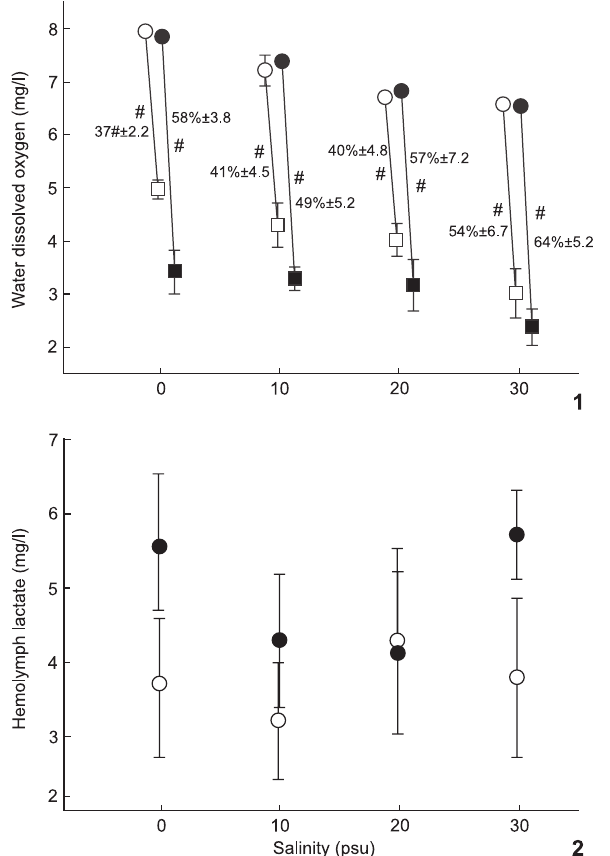
Figures 1–2. Initial (circles) and final (squares) levels of dissolved oxygen in the water (1) and lactate concentration in the hemolymph (2) of M. acanthurus exposed to salinities 0 (control), 10, 20, and 30 psu for 4 (white symbols) and 8 hours (black symbols). Values near to the lines represent oxygen consumption (mean ± std dev) as a percentage of the initial oxygen concentration (considered 100%, as a reference value). (#) Initial and final levels of dissolved oxygen are different. There were no significant differences between salinities or times (4 and 8 hours) for oxygen consumption and lactate concentration.